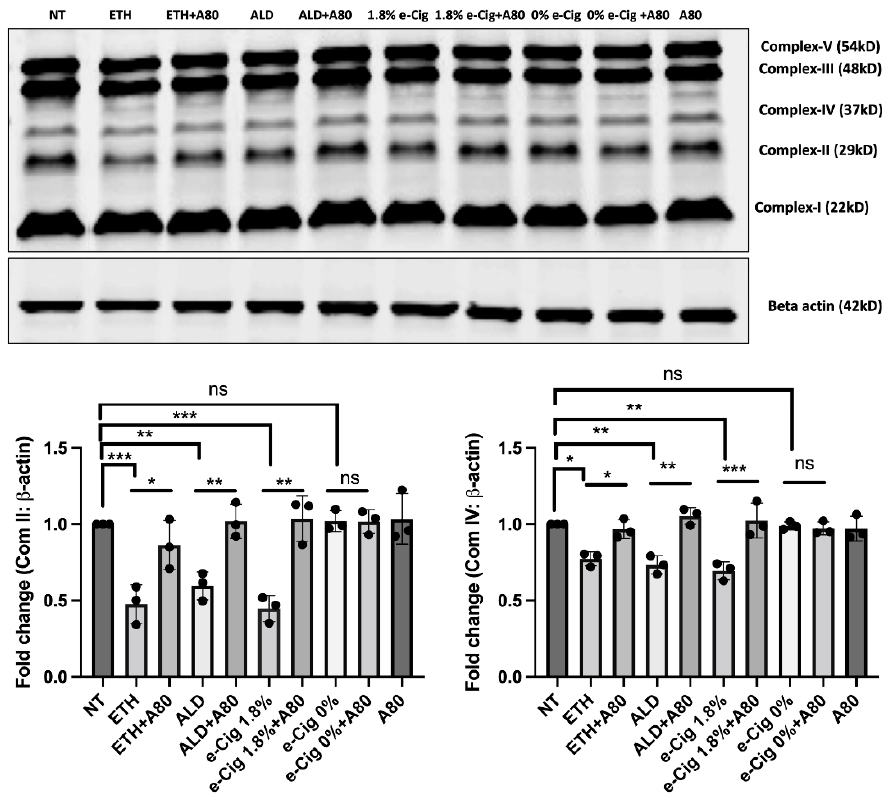
Figure 2. P2X7r inhibitor A804598 protected the expression of mitochondrial OXPHOS proteins against ETH, ALD, or 1.8% e-Cig exposure. When compared with control group hBMVECs incu- bated with ETH, ALD, and 1.8% e-Cig conditioned media reduced the expression of mitochondrial complex-II and complex-IV by 45% and 30%, respectively. Cells treated with A804598 (A80) pre- served the expression of mitochondrial complexes ( n = 3). Western blot data were normalized with β -actin and one-way ANOVA was used for the statistical analyses, marked as * p ≤ 0.05, ** p ≤ 0.01, *** p ≤ 0.001 and ns (not significant).